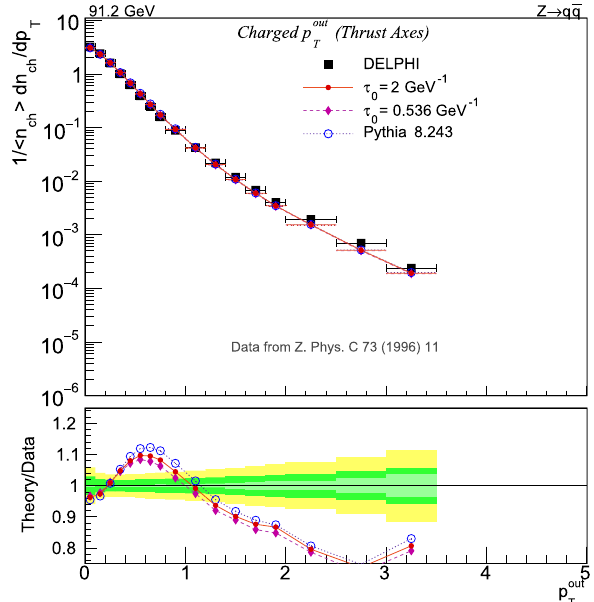
Fig. 4 The out-of-plane charged-particle p ⊥ distribution, as measured along the Thrust minor axis. Data from